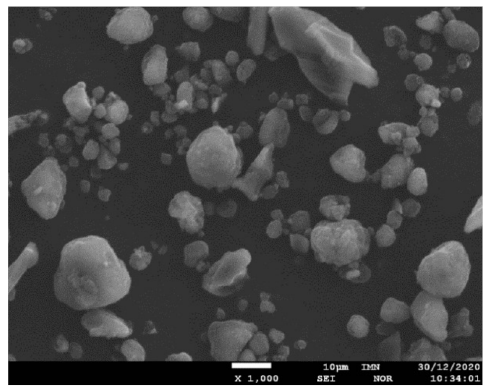
Figure 4. SEI microscopic picture of the analyzed activated carbon; zoom 1000 ×